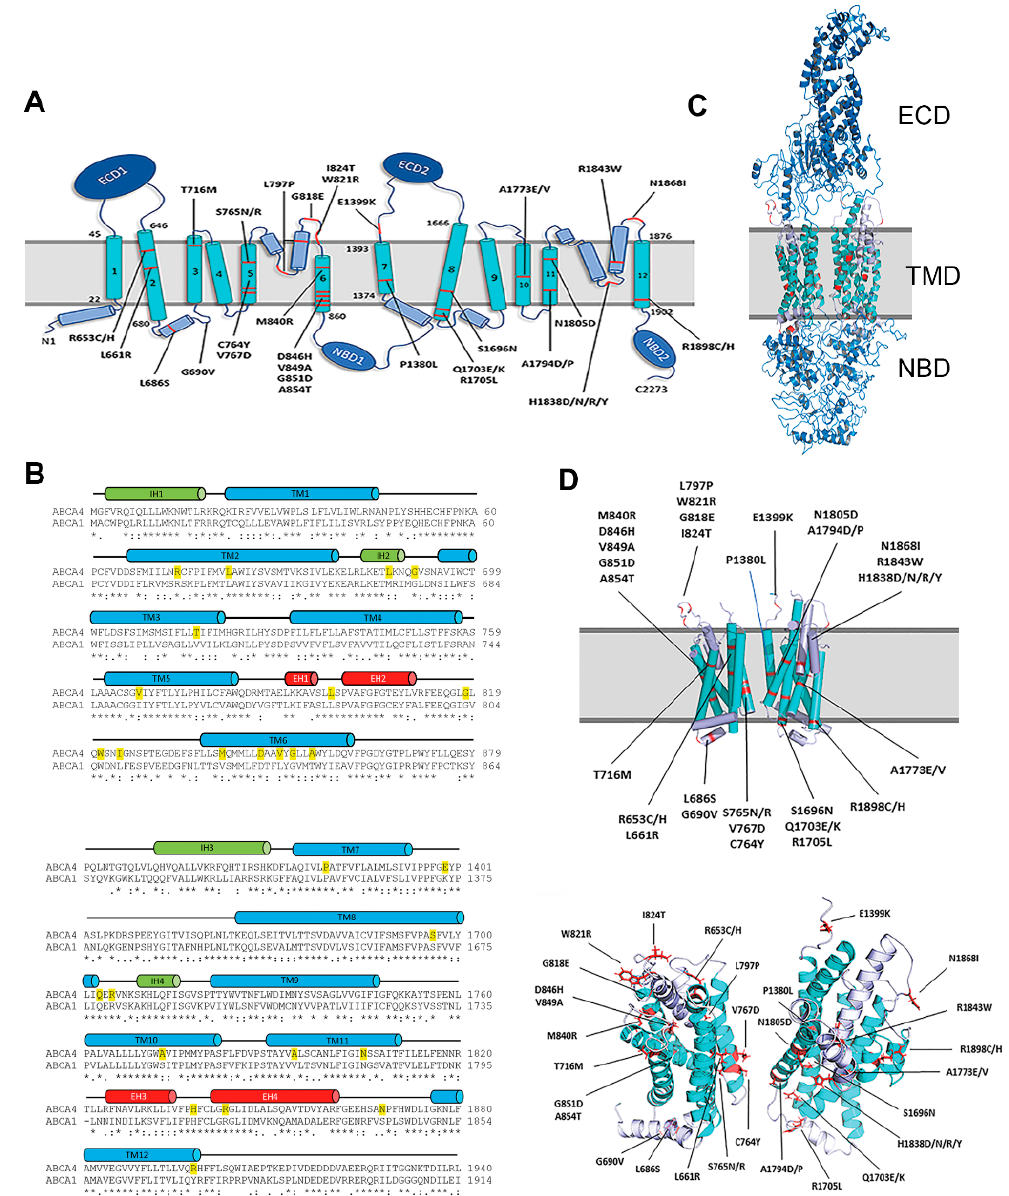
Figure 1. Location of TMD missense mutations in ABCA4 associated with STGD1. ( A ) Topological model of ABCA4 showing the location of mutations in TMD1 and TMD2. ECD—Exocytoplasmic Domain; TMD—Transmembrane Domain; NBD—Nucleotide Binding Domain. ( B ) Sequence alignment of the Transmembrane Domains TMD1 and TMD2 of ABCA4 and ABCA1 using Clustal Omega. The locations of the α -helical membrane spanning segments are shown as blue cylinders (TM1-12), intracellular transverse coupling helices are in green (IH1–IH4), and exoplasmic V-shaped α -helical hairpin helices are in red (EH1–EH4). The STGD1 missense variants examined in this study are highlighted in yellow. ( C ) Homology model of ABCA4 based on the cryoEM structure of ABCA1. ( D ) The location of disease-causing mutations within the TMD1 and TMD2. Top: Transverse view relative to the membrane with the transmembrane segments shown as cylinders. Bottom: Top view relative to the membrane with the transmembrane segments shown as ribbons.